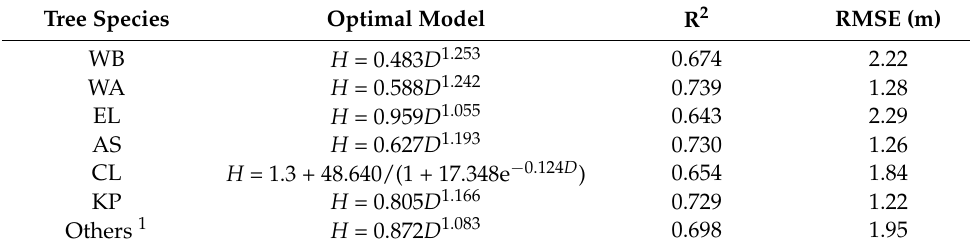
Table 8. Optimal tree height curve model of main tree species. Tree Species